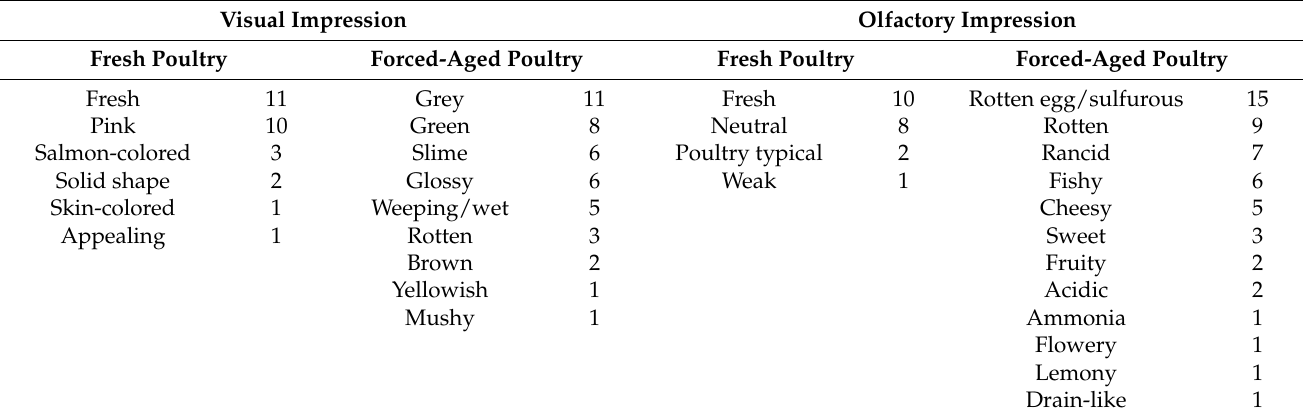
Table 1. Results of the descriptive analysis for the visual and olfactory attributes named by the panel for a fresh and forced-aged (4 days at 23 ◦ C) poultry